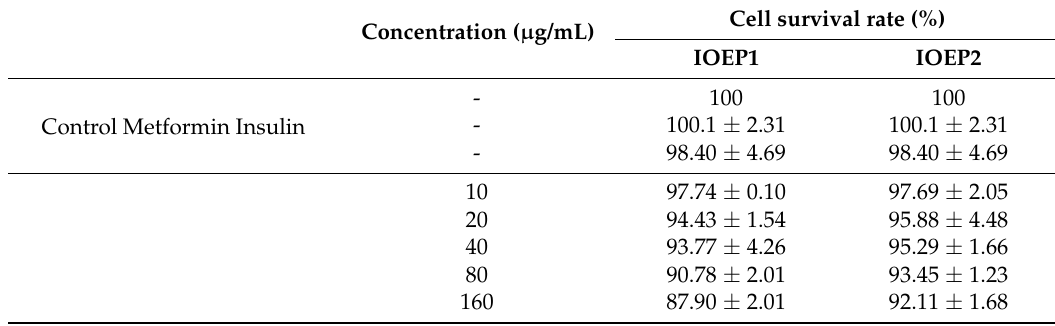
Table 2. Toxicity of different concentrations of IOEP1 and IOEP2 on HepG2 cells.